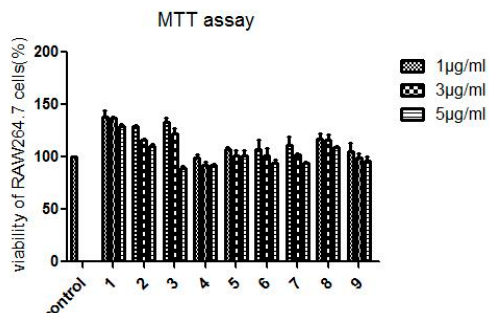
Figure 2. The cellular viabilities of RAW264.7 cells treated with compounds 1 – 9 . All the data are expressed as means ± SD of three independent experiments.